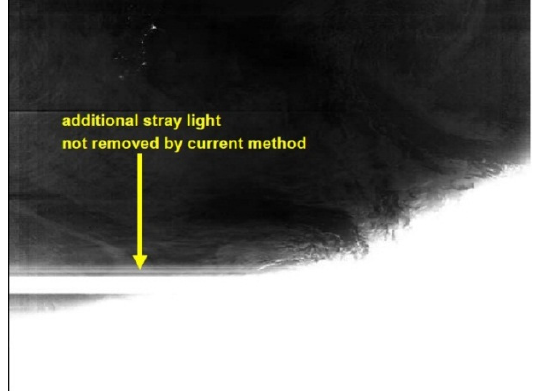
Figure 8. DNB image from October 5, 2013, 5:06 GMT, corrected by the current method. The residual artifact from additional stray light can be seen as a large swath across the image.